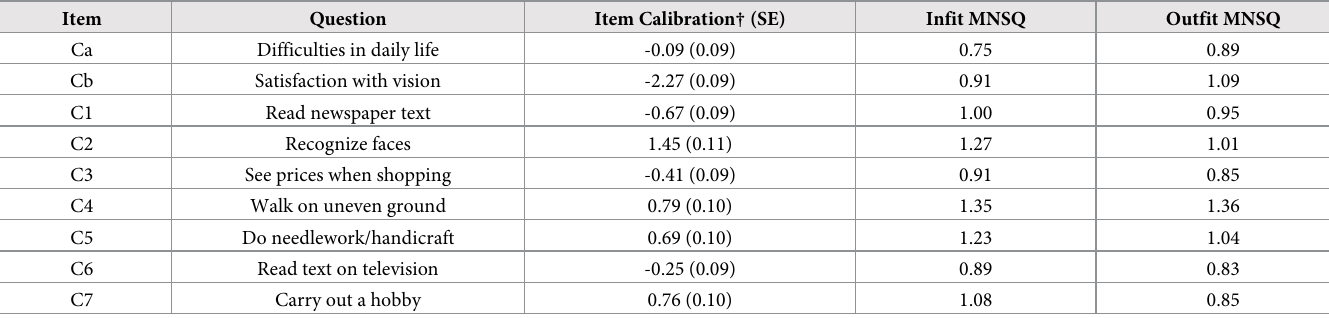
Table 2. Rasch analysis results of full